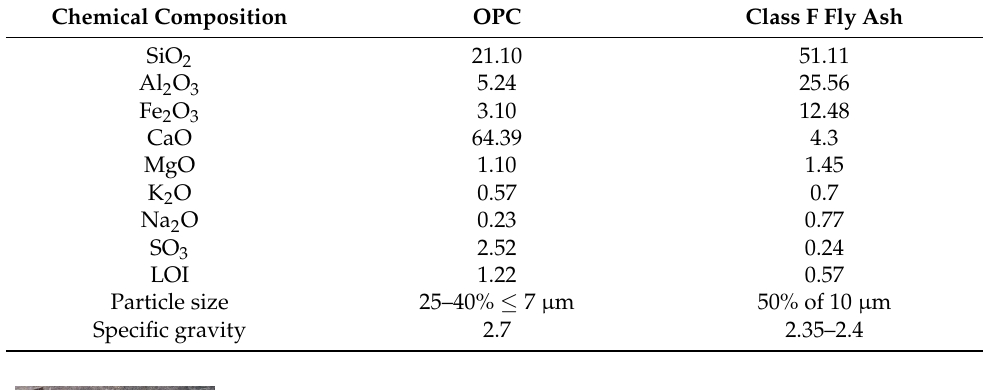
Table 1. Chemical composition and physical properties of OPC and Class F fly ash in wt. % [18].